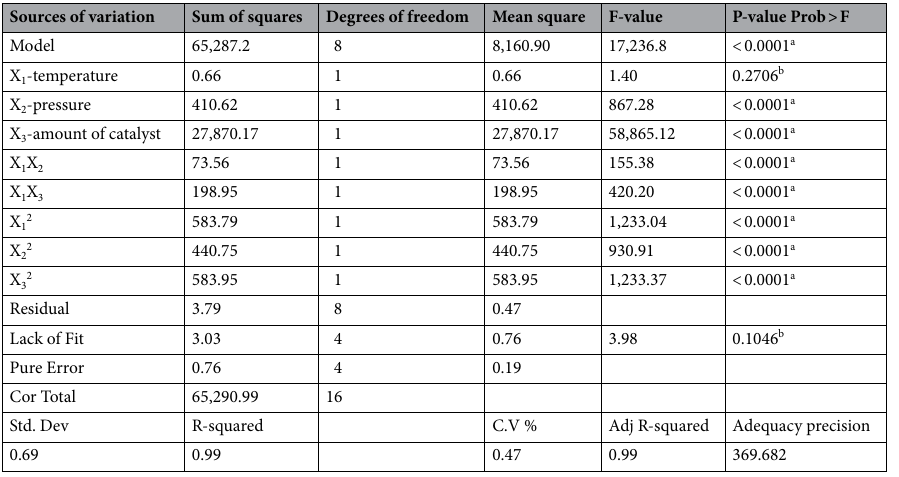
Table 4. ANOVA results of the quadratic model for catalytic oxidation of ethyl benzene. a Significant. b